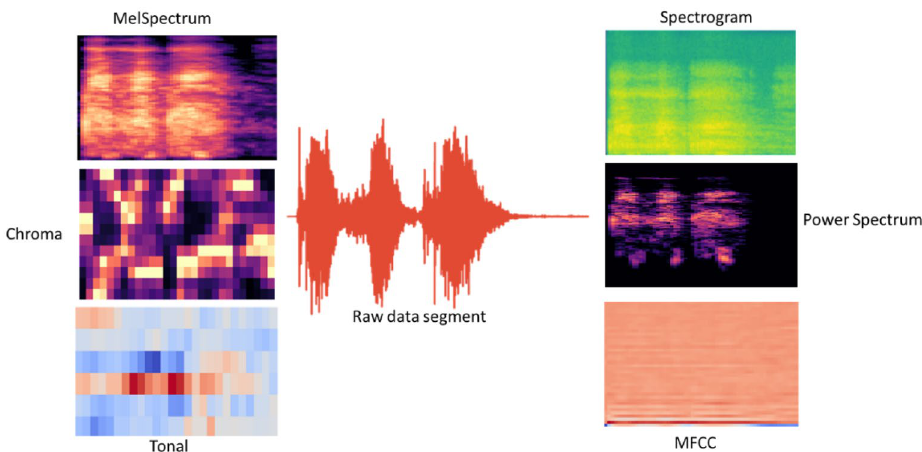
Figure 2. An example of raw cough sound data with the associated six